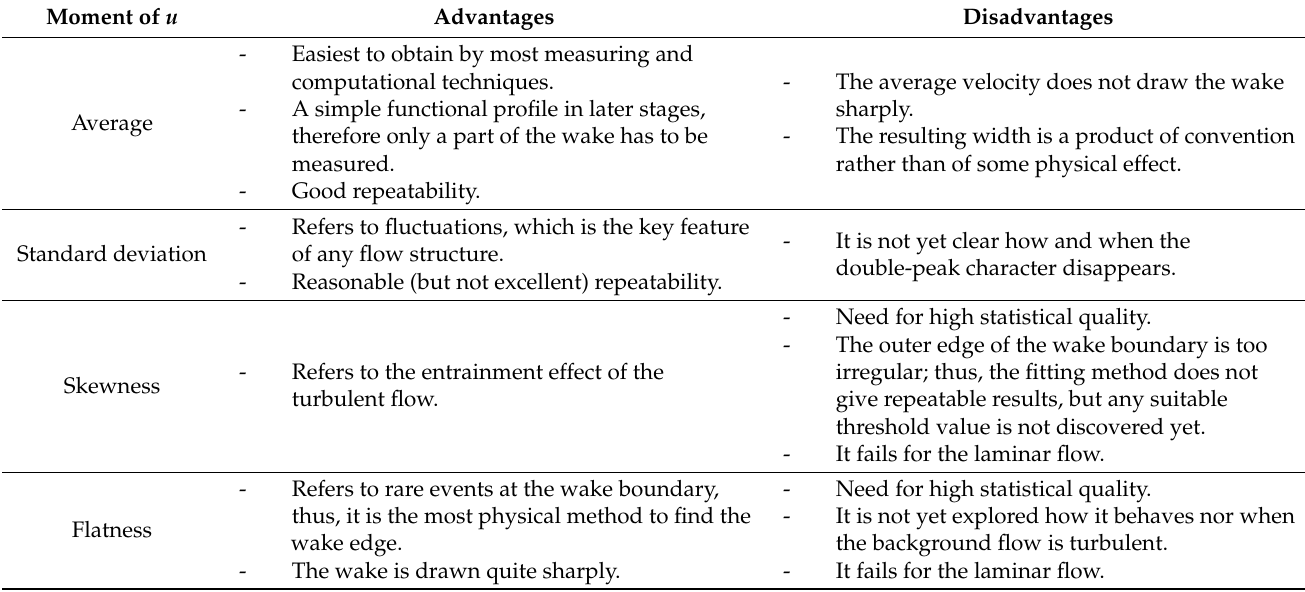
Table 2. The momenta of stream-wise velocity, which have been examined in this